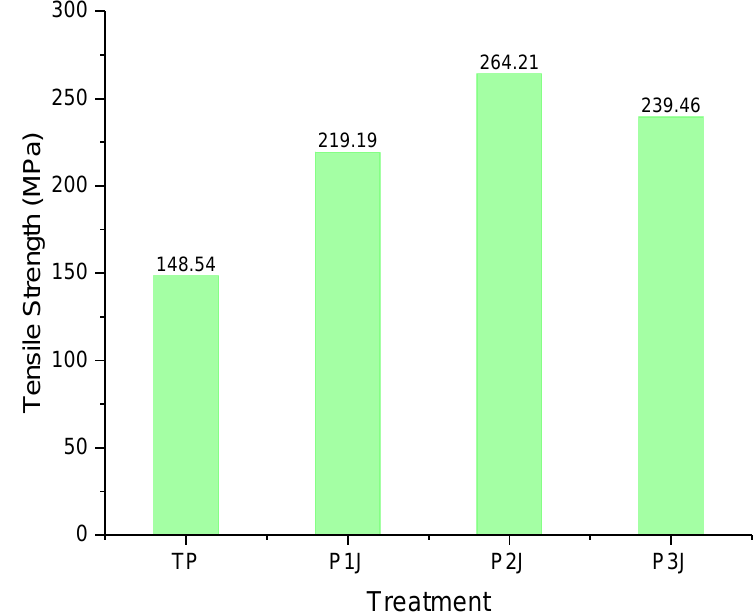
Figure 3. Single fiber strength test (TP, P1J, P2J, and P3J).